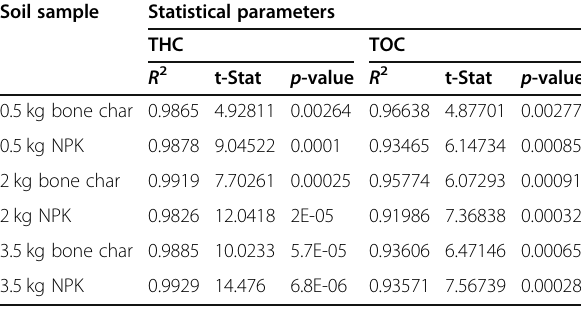
Soil sample Statistical